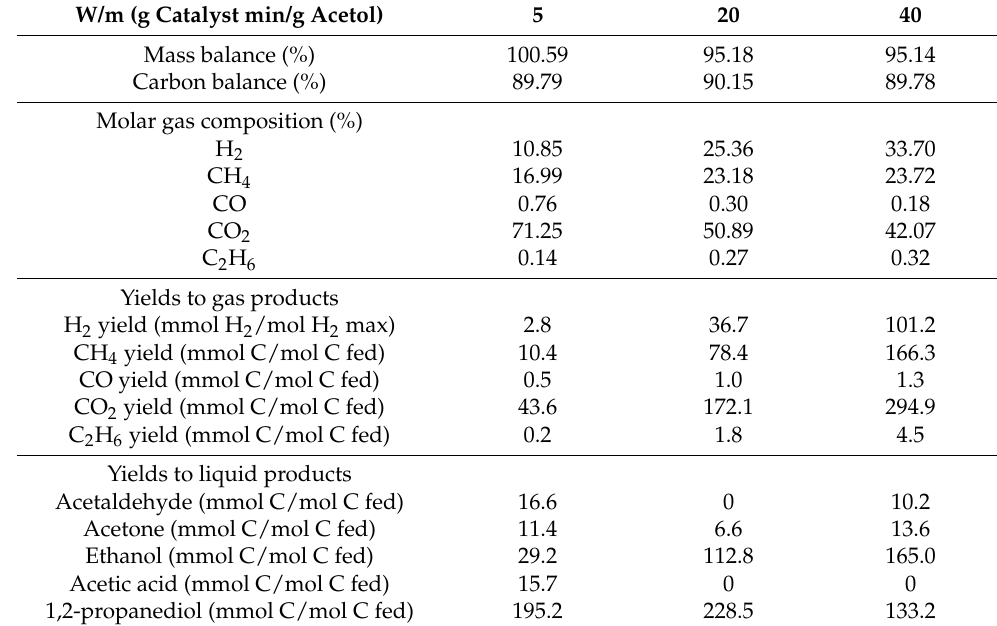
Table 2. Results of the APR experiments of acetol (T = 227 ◦ C, 40 bar, 5 wt% acetol, Ni-Co/Al-Mg catalyst, 1 mL/min aqueous feeding